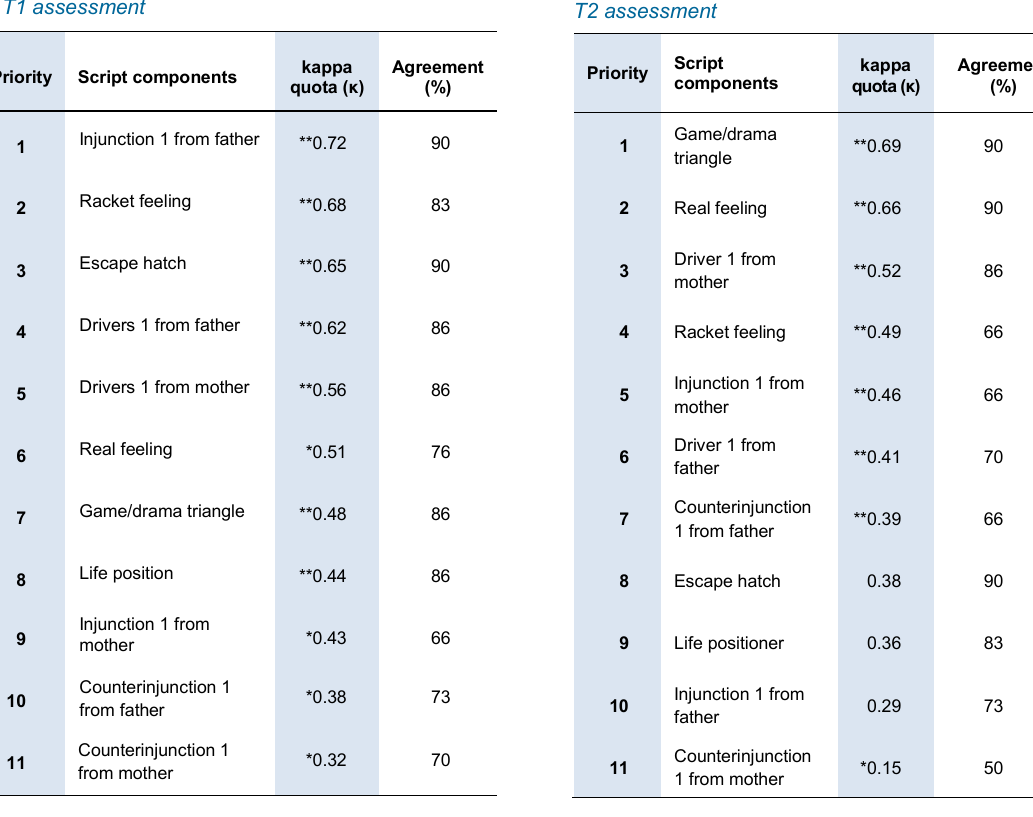
Table 7: Ranking of script components for 10 clients